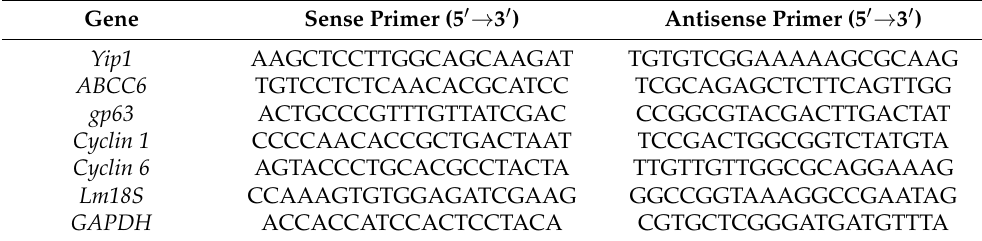
Table 1. Primer sequences used for the quantification of Leishmania genes. Gene